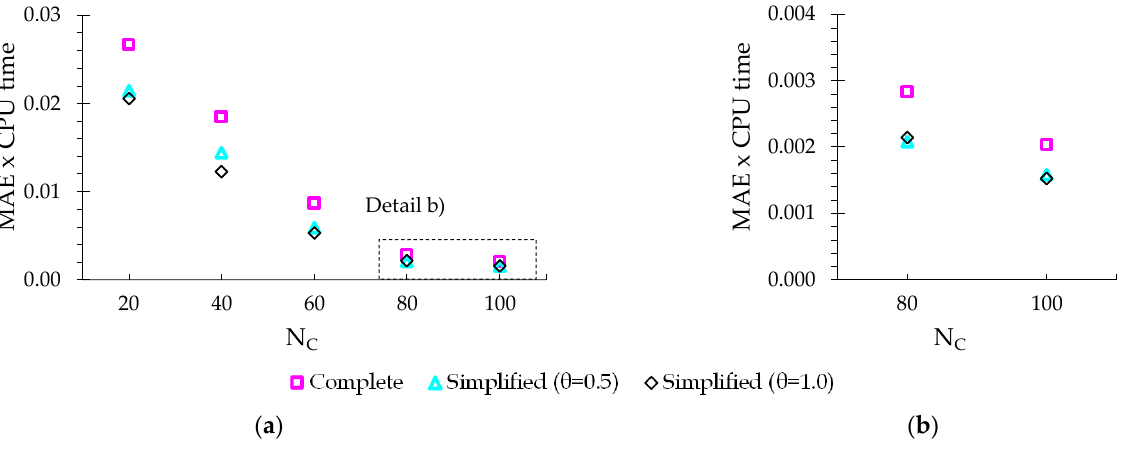
Figure 18. MAE and CPU time product calculation for the three numerical schemes using 1D Zielke model as benchmark: ( a ) for 20 ≤ N C ≤ 100 ; and ( b ) detail for N C = 80 and 100.